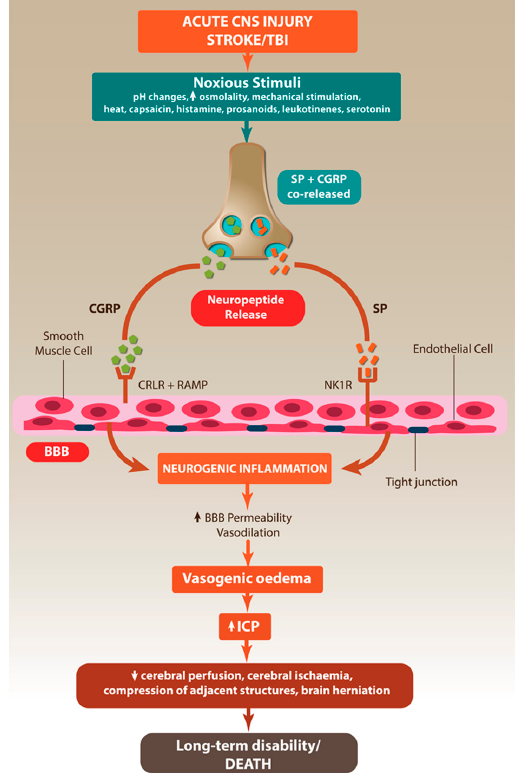
Figure 2. Neurogenic inflammation in acute central nervous system (CNS) injury. Acute CNS injury stimulates the release of neuropeptides, which lead to the development of neurogenic inflammation in the CNS, characterised by vasodilation, increased blood-brain barrier (BBB) permeability and cerebral oedema. Arrows indicate sequence of events following acute CNS injury.